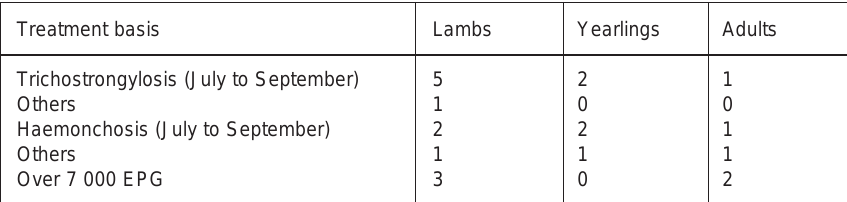
TABLE 3 The number of Dorper lambs, yearling and adults given salvage treatment based on clinical manifestation of nematodosis and egg counts (over 7 000 EPG) between